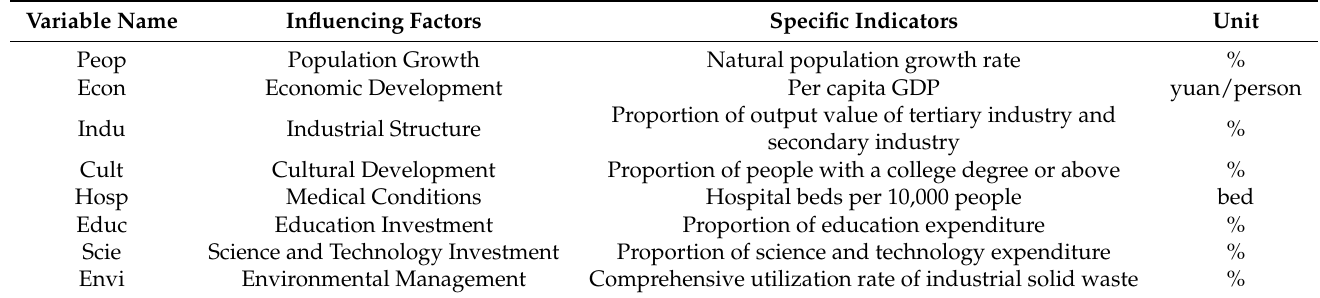
Table 3. Index system of influencing factors of GLUE in resource-based cities.